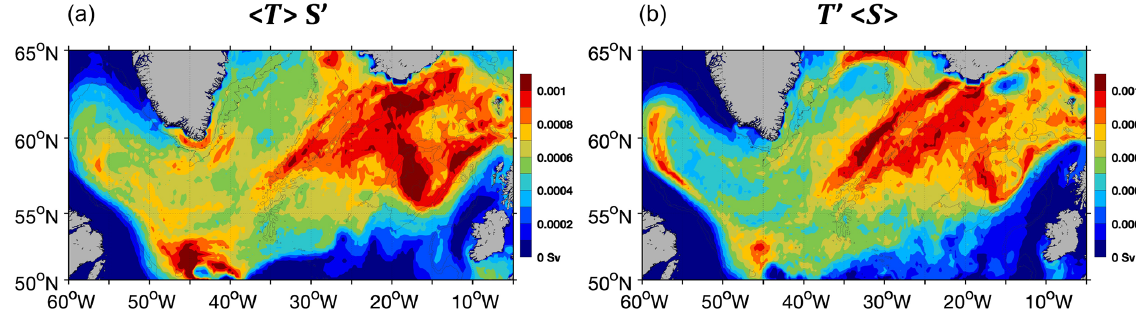
Figure A2. Variance in SPMW transformation (27.3–27.5kgm − 3 ) estimated from (a) monthly variable surface salinity and climatological surface temperature and (b) monthly variable surface temperature and climatological surface salinity during